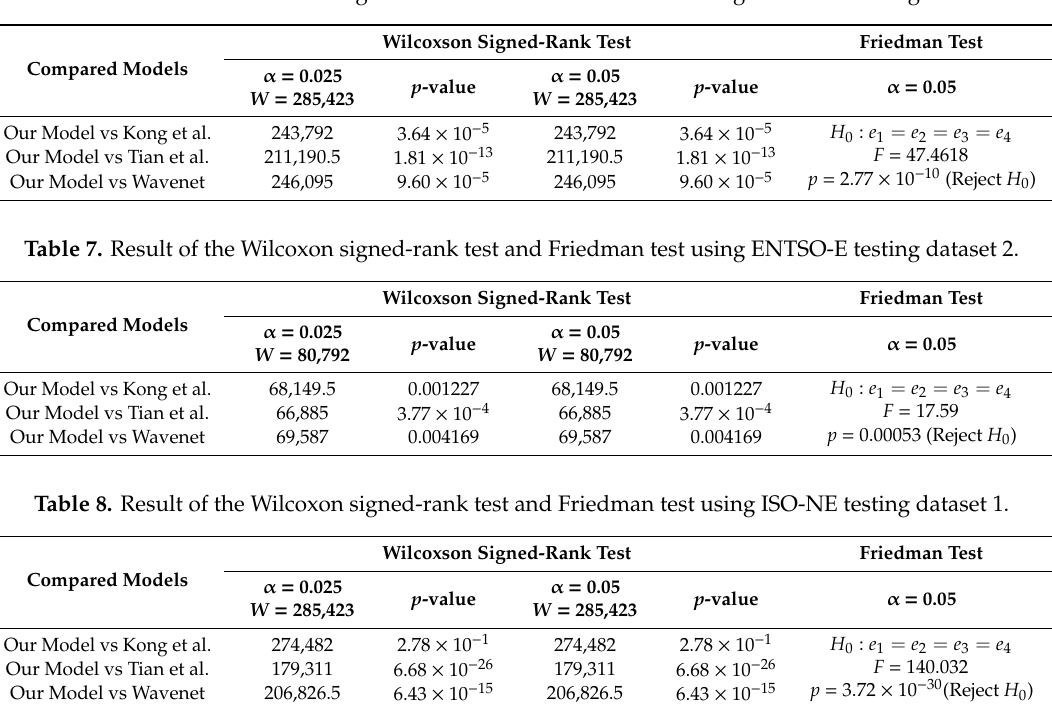
Table 6. Result of the Wilcoxon signed-rank test and Friedman test using ENTSO-E testing dataset 1. Compared Models